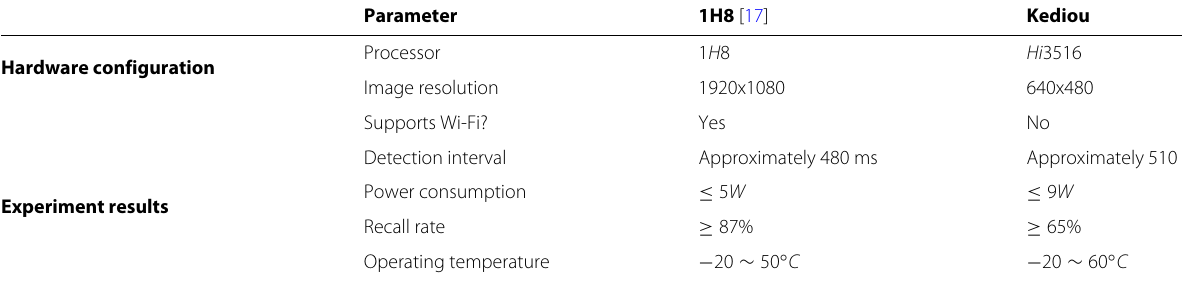
Table 6 Comparison of the 1H8 and